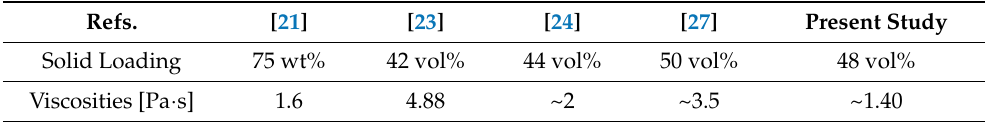
Table 2. A brief review on viscosities of zirconia suspensions used for DLP process. Refs.